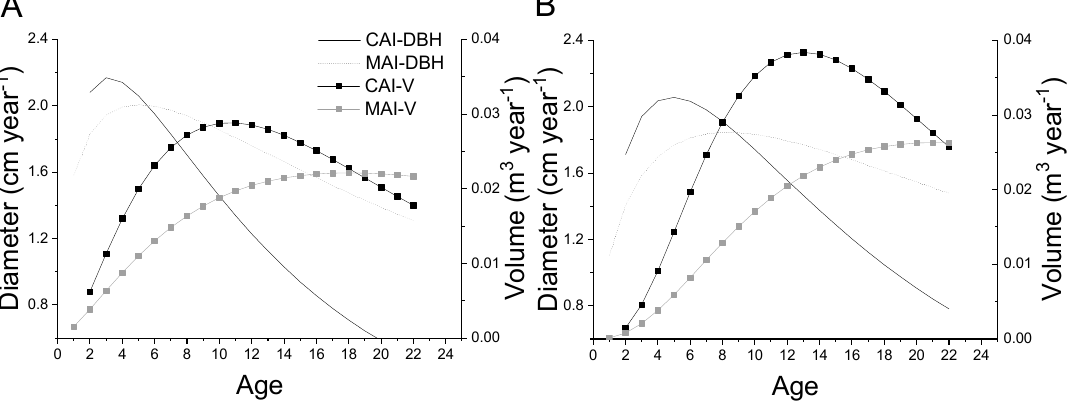
Figure 4. Current (CAI) and mean (MAI) annual diameter and wood volume increments of P. patula trees: ( A ) unthinned and ( B ) thinned stand.